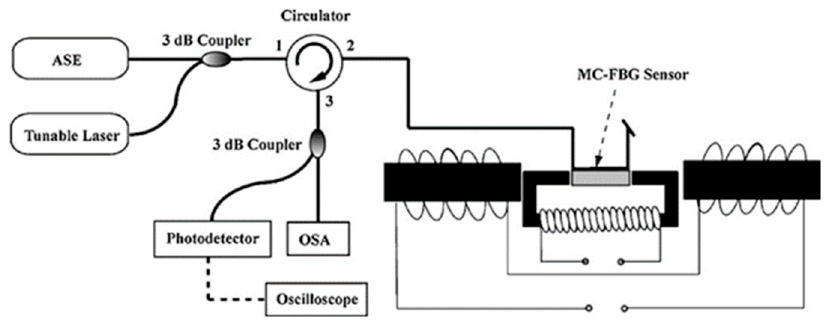
Figure 6. Sensor system diagram.